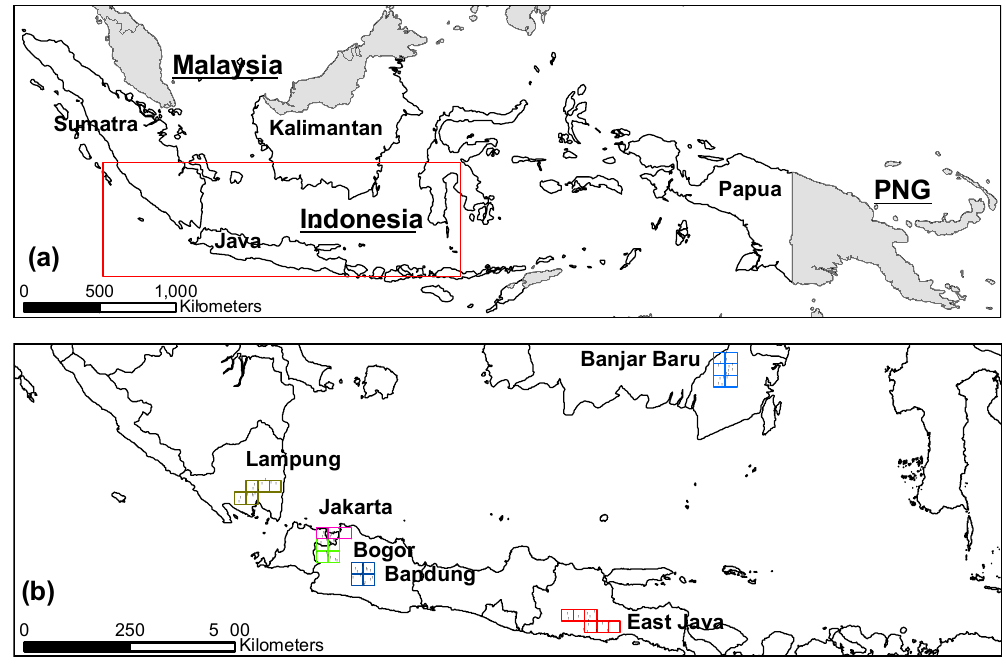
Fig. 1. (a) Map of Indonesia (and Malaysia, Brunei, Singapore, Papua New Guinea (PNG) and East Timor, grey areas). The red box is shown in more detail in (b) . (b) TMPA 3B42RT validation areas indicated in different colours. Each square represents one satellite grid cell of 0.25 ◦ × 0.25 ◦ . The black dots are the locations of the ground stations. Table 1. Descriptive characteristics of the validation areas. Ground station data coverage for the period 2003–2008. Elevation determined from SRTM 90 m resolution (Jarvis et al., 2008). Forest and urban cover determined from GlobCover v2.2 regional land cover map over Southeast Asia (ESA, 2008).